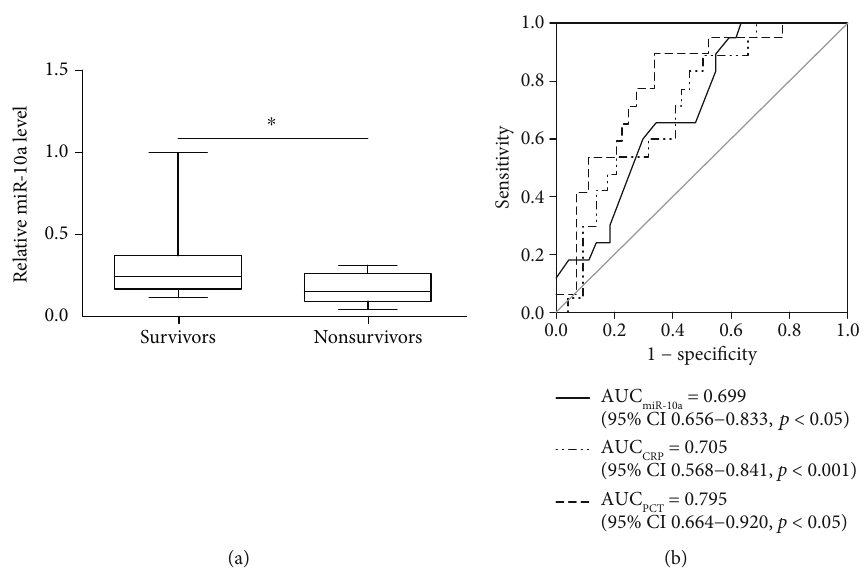
Figure 4: ROC curves for the prediction of 28-day mortality. (a) PBMC miR-10a levels were compared between nonsurvivors ( n = 17 ) and survivors ( n = 45 ). (b) ROC curves present sensitivity and speci fi city of PBMC miR-10a, CRP, and PCT for predicting 28-day mortality.